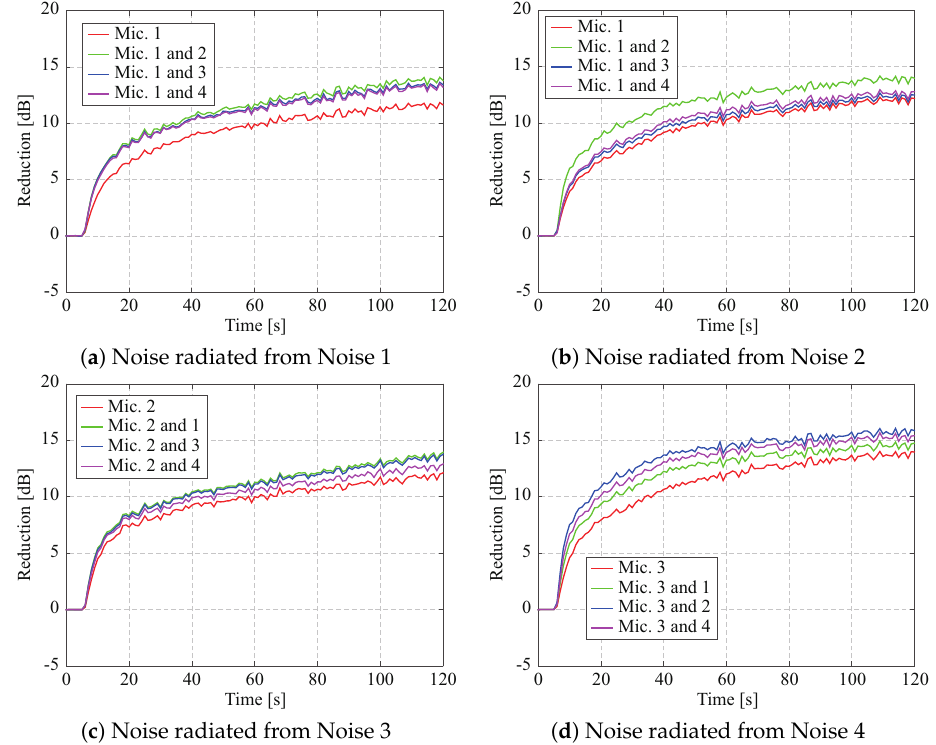
Figure 11. Noise reduction performance of a two-channel feedforward ANC system in the experiment.